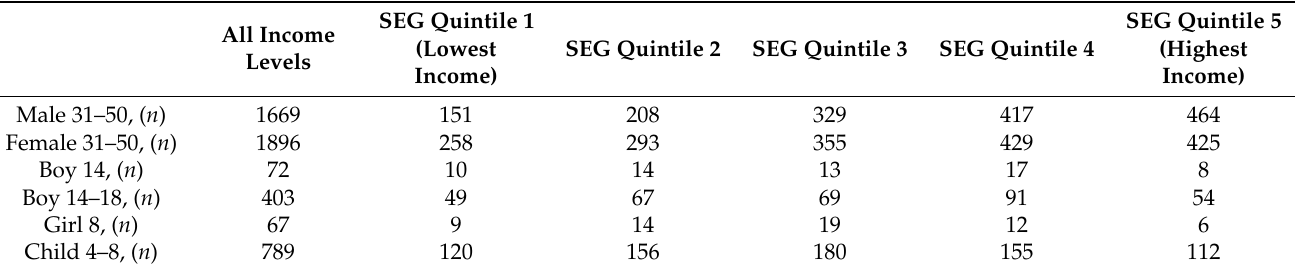
Table 1. Participant numbers in subcategories in the ABS